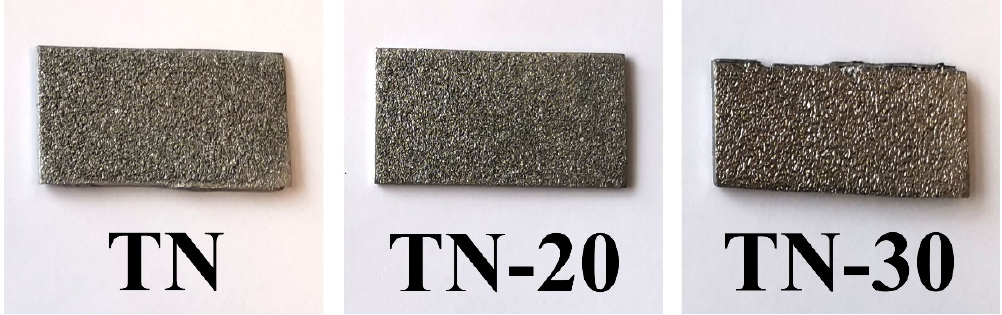
Figure 1. Photographs of samples TN, TN-20 and TN-30.